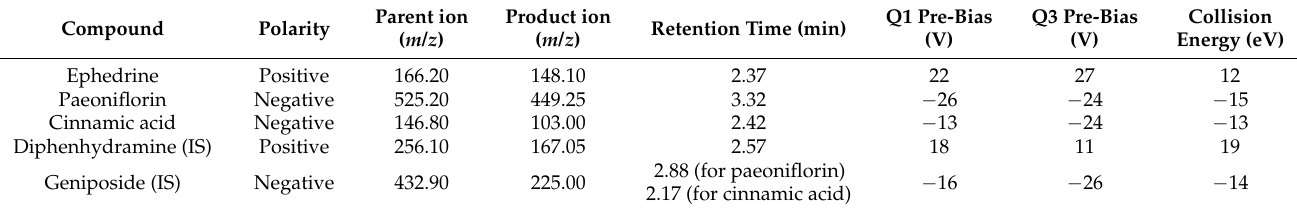
Table 1. Optimized mass spectrometry analysis conditions of